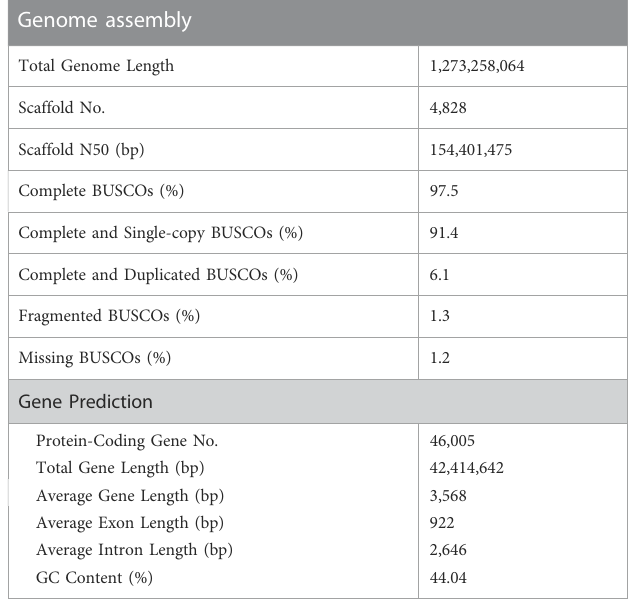
TABLE 1 Summary statistics of genome assembly and gene prediction of C. lanceolata